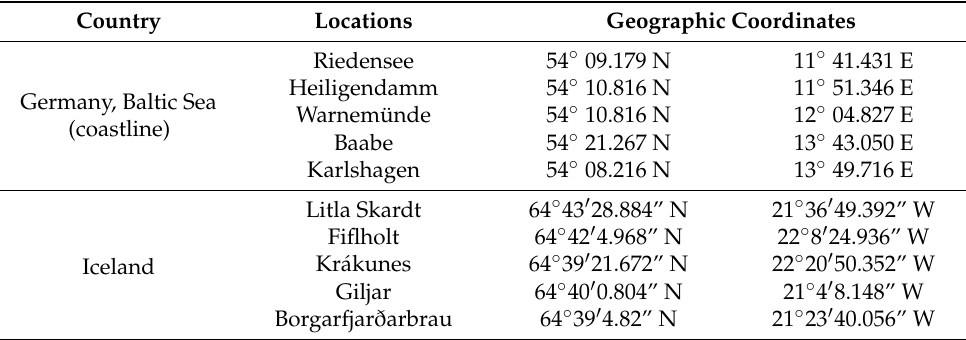
Table 1. Geographical coordinates of biocrust sampling